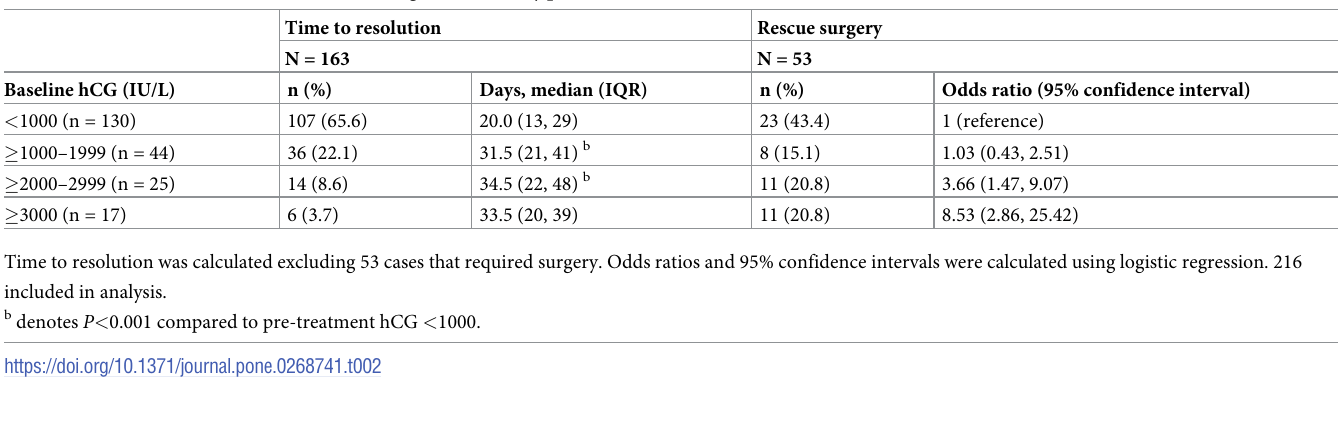
Table 2. Time to resolution and likelihood of surgical excision by pre-treatment